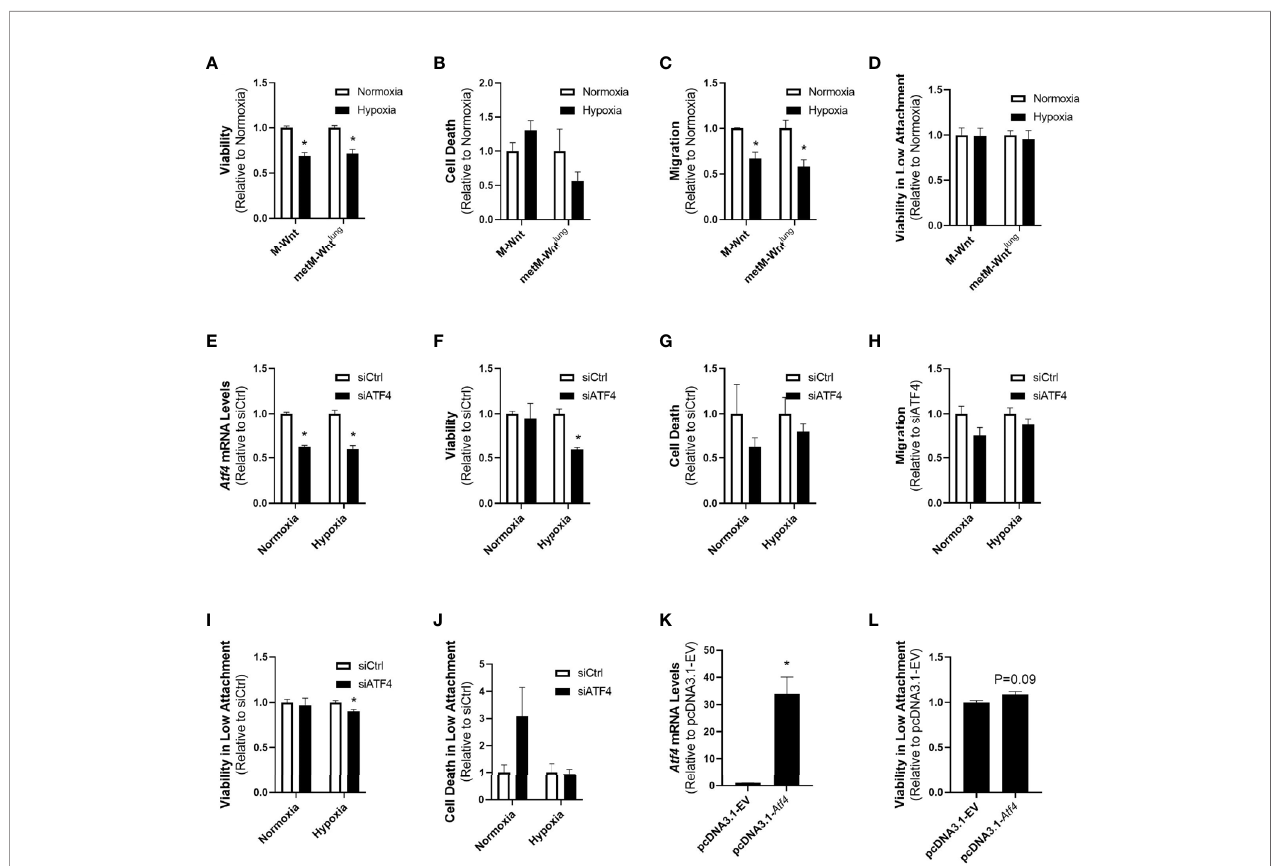
FIGURE 4 | Effect of ATF4 manipulation in normoxic and hypoxic cells. Viability after 48 h in hypoxia or normoxia was assessed by MTT (A) . Cells were pre- incubated in normoxia or hypoxia for 48 h and cell death was determined by fl ow cytometry with Zombie NIR (B) , re-plated into transwells to assess migration (C) or low attachment plates to assess viability in detached conditions (D) . metM-Wnt lung cells were transfected with siCtrl or siATF4 and incubated in hypoxia or normoxia for 48 h. ATF4 depletion was con fi rmed by qRT-PCR (E) . Cell viability (F) and cell death (G) were assessed at the end of incubation. Cells pre-incubated in hypoxia or normoxia were seeded into transwells to assess migration (H) or low attachment plates to assess viability (I) and cell death (J) in detached conditions. M-Wnt cells were transfected with pcDNA3.1-EV or pcDNA3.1- Atf4 and incubated in normoxia for 48 h. ATF4 overexpression was con fi rmed by qRT-PCR (K) . Cells were seeded into low attachment plates to assess viability in detached conditions (L) . Results are expressed as mean + SEM. Asterisk (*) indicates P < 0.05 relative to normoxia (A – D) or P < 0.05 relative to siCtrl or empty vector (E – K) ,